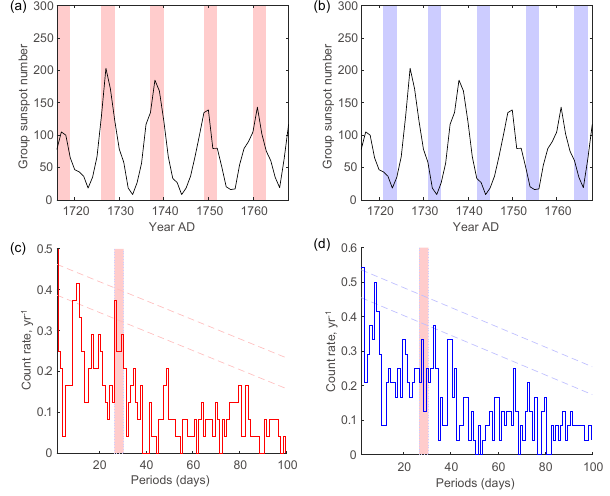
Figure 2. (a) Number of lightning events from May to August dur- ing AD1668–1767 excavated from five old diaries in Kyoto, Japan. Note that the long-term differences in the numbers of lightning events in the 17th and 18th centuries may not exactly reflect the actual lightning activity level, as mentioned in the text. (b) Sunspot numbers over the same period (Clette and Lefevre, 2016, black line; Hoyt and Schatten, 1998, blue line). Blue shading indicates the pe- riod of the Maunder Minimum (Eddy, 1976).